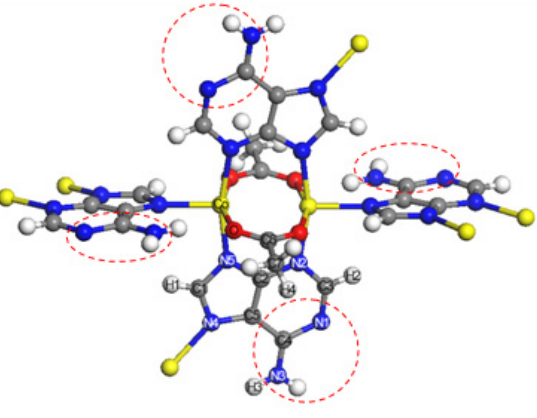
Figure 5. The most favorable adsorption sites of bio-MOF-11 cluster. (Co, yellow; C, grey; H, white; O, red; and N,